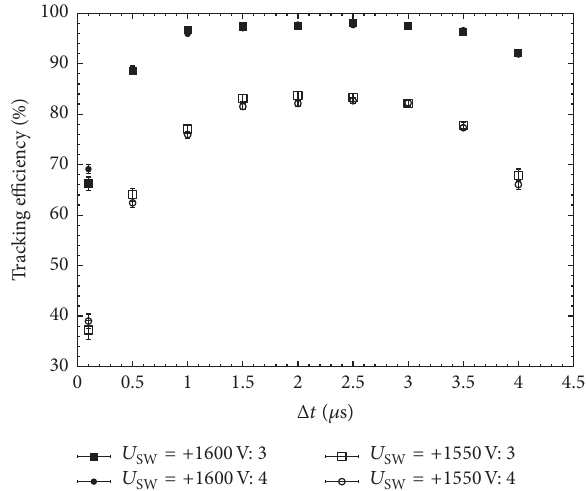
Figure 5: Signal amplitude spectra in the first detector layer for tracks with at least 5 points ( dashed lines ), and for tracks with 6 points ( continuous line ) with the approximate detection level of 120 ADC units. The peak around zero amplitude corresponds to those tracks which miss the first layer.